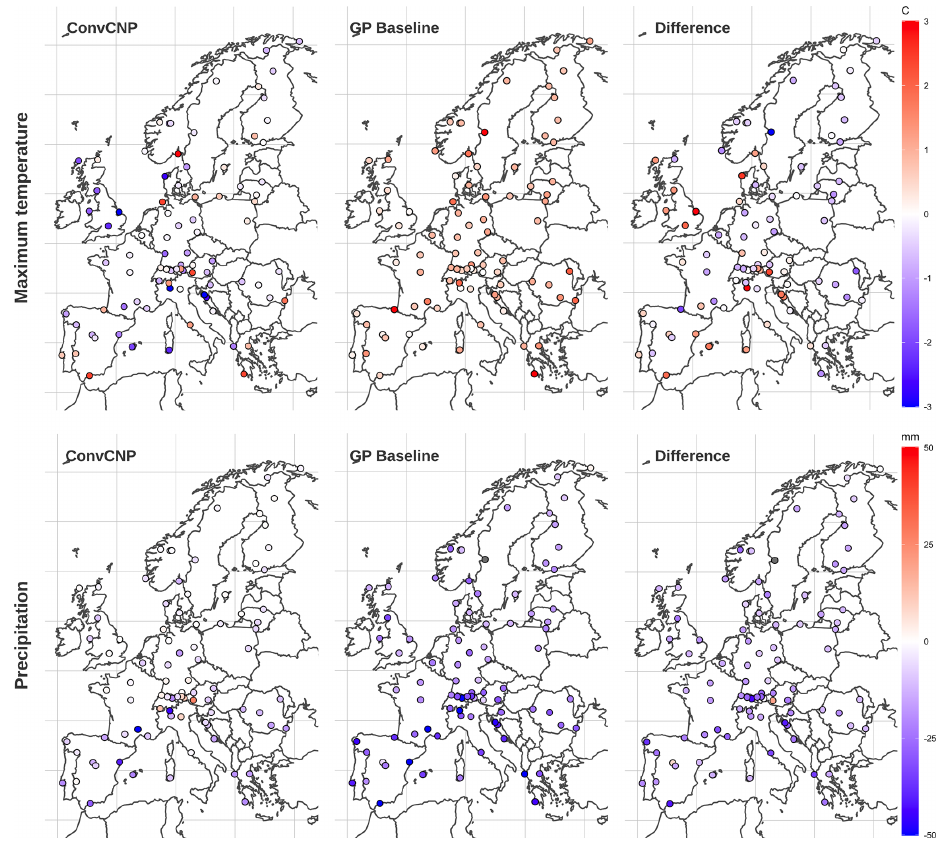
Figure 9. The same as for Fig. 7 but for P98 biases. Here, the “difference” panels quantify the difference in absolute bias | P 98 convCNP |− | P 98 | . Negative (positive) values indicate that the convCNP (GP-baseline) has better GP-baseline